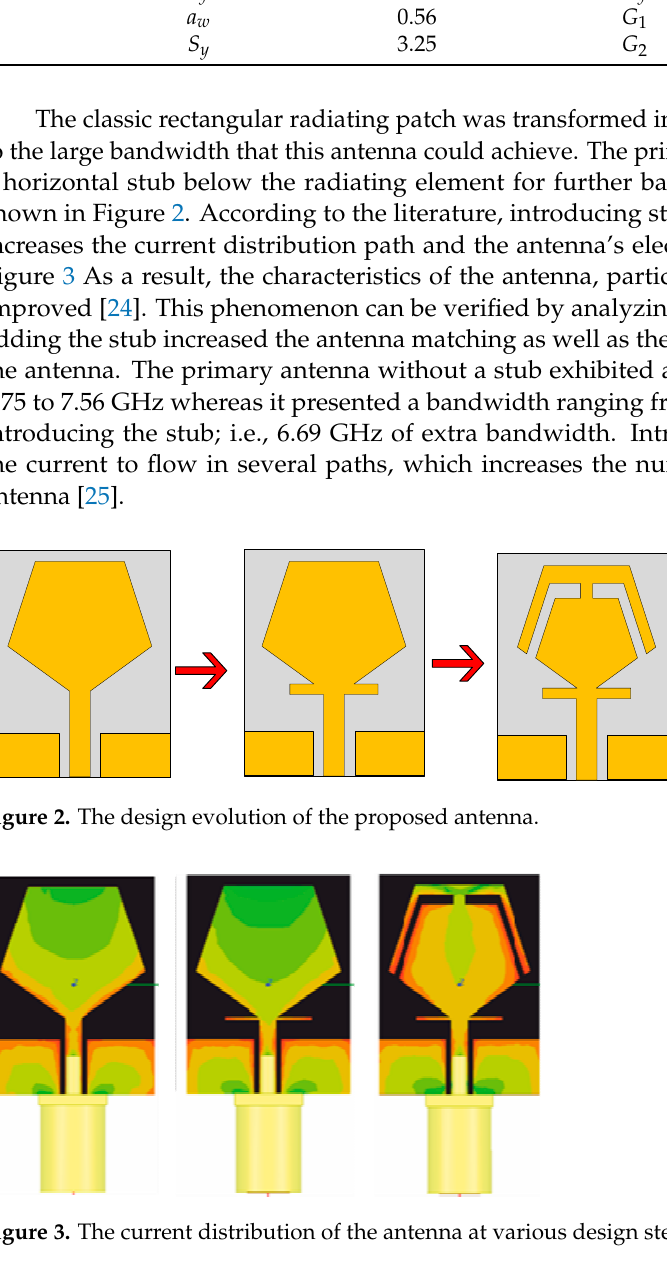
Figure 4. VSWR response of the radiating element with and without the stub. 2.2. Design of a Notch Band Antenna Although UWB antennas are highly desirable for future devices due to their consid- erable bandwidth, this type of antenna presents a significant challenge. Due to this large bandwidth, the antenna may be prone to interference from adjacent systems that reside in the UWB region. Among the most common sub-bands that we sought to mitigate were wireless local area networks (WLANs) (3.35 GHz (3.3 − 3.4 GHz), 3.5 GHz (3.4 to 3.6 GHz), 3.7 GHz (3.6 to 3.8 GHz) and 5.7 GHz (5.725 to 5.85 GHz)), WiMAX (3.4 and 5.8 GHz), the first segment of the sub-6-GHz band (3.4–3.7 GHz) of the 5G communication network and many other communication systems. Filters are commonly used to attenuate the adjacent bands and therefore enhance the communication quality. However, this technique pre- sents the drawback of insertion losses as well as the increase in volume and complexity of the resulting antenna [26]. Thus, the researchers mainly focused on more practical tech- niques to avoid potential interference from existing adjacent bands. These band rejection approaches included etching out the split-ring (SRR) and complementary split-ring reso- nators (CSRR), which exhibit a stop-band when excited by a time-varying axial electric field as illustrated in [27,28]. Other techniques have been considered such as introducing slots on the radiating element [26,29] and DGS in the ground plane [19,30] or using para- sitic elements [31] or by combining multiple techniques [32]. In this paper, we considered notching the unwanted bands using slots introduced in the radiating patch. This approach is the most frequently used to reduce interference between bands for the promising results it achieves while maintaining a compact geometry with a simple design.